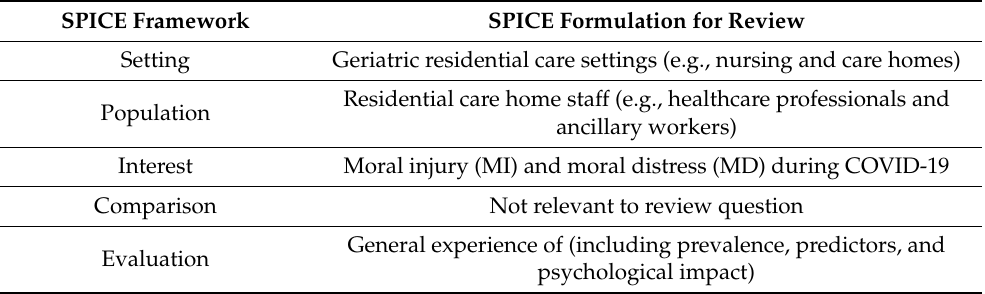
Table 1. SPICE framework and formulation.